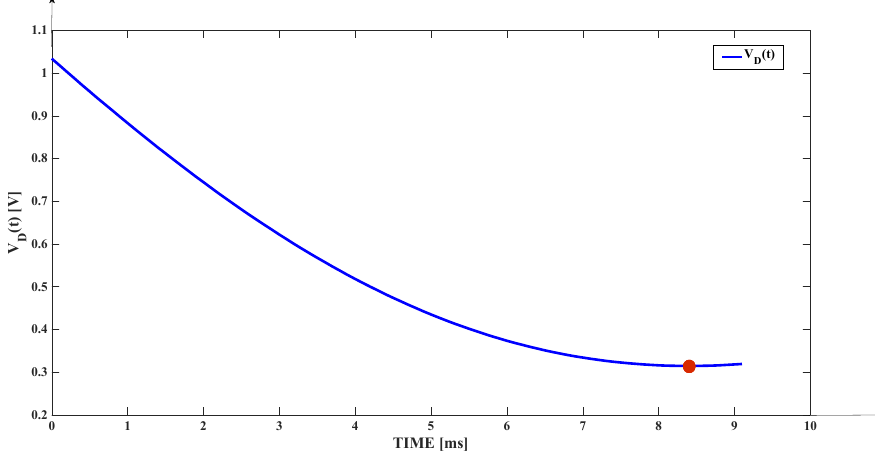
Figure 23. Highlighting the detection of an event that is not classified as a fault.